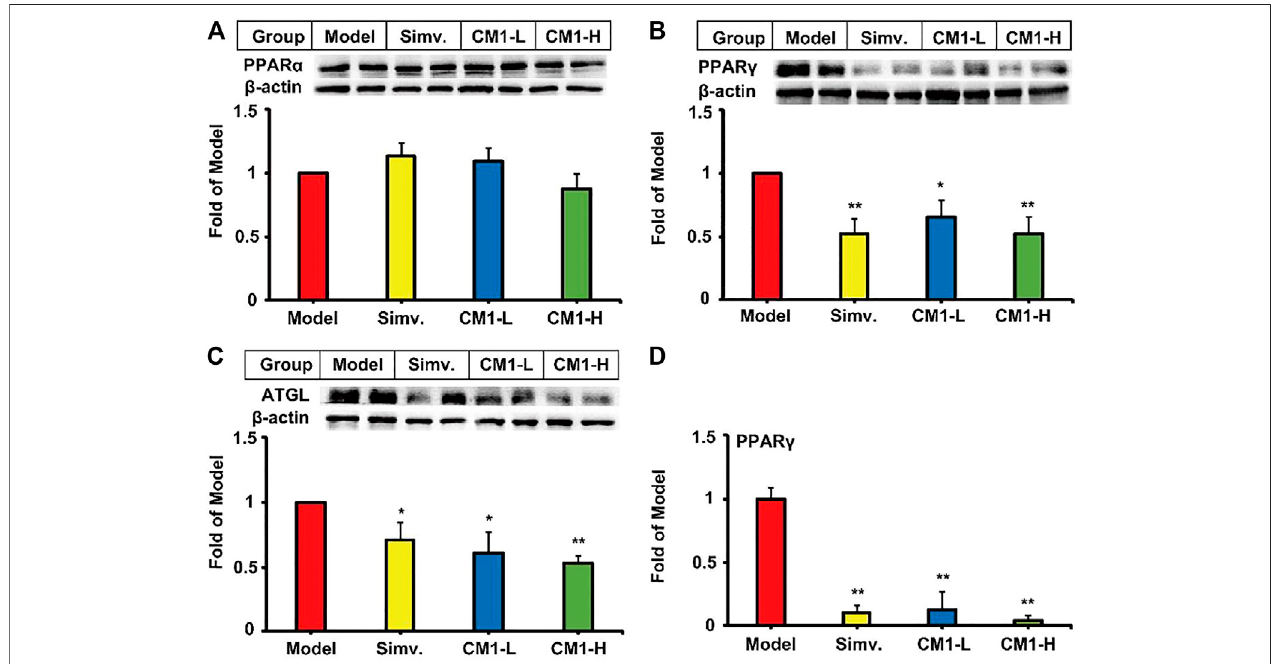
FIGURE7| EffectofCM1ontheexpressionoflipidmetabolismrelatedgenesandproteinsintheepididymalfatoftheLDLR (-/-) mice( n ≥ 4).Proteinexpressionand densitometric quanti fi cation. (A) , PPAR α ; (B) , PPAR γ ; (C) , ATGL; (D) , mRNA expression of PPAR γ . *means p < 0.05 vs . Model, and **means p < 0.01 vs .